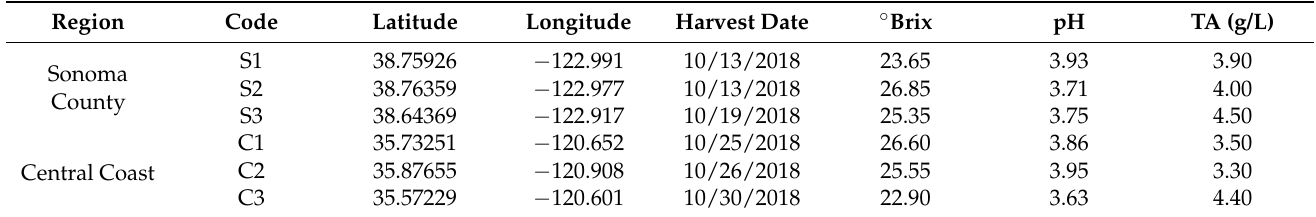
Table 1. Vineyard coordinates, sample codes, harvest date and basic chemical analysis for all the grapes analyzed. C-Central Coast, S-Sonoma County. Numbers 1, 2, 3 refer to sites within the same region. TA refers to titratable acidity expressed in g/L of tartaric